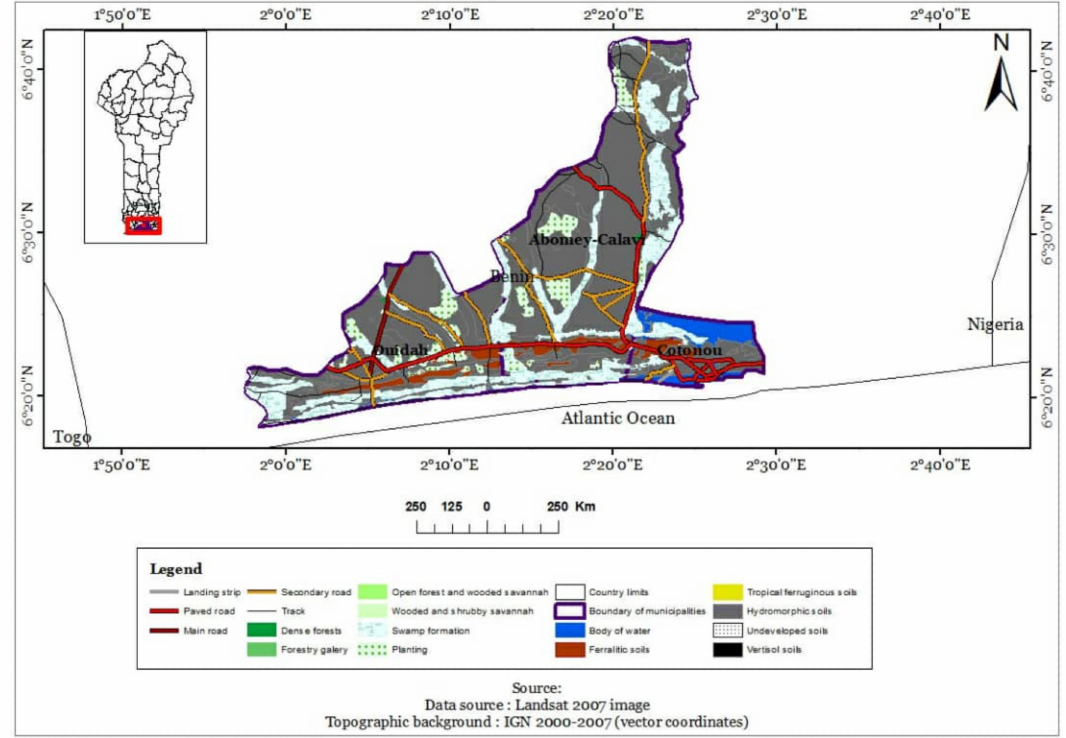
Figure 1. Map showing the location of the surveyed districts in Southern Benin. Location of the surveyed districts in Southern Benin, vegetation and soil